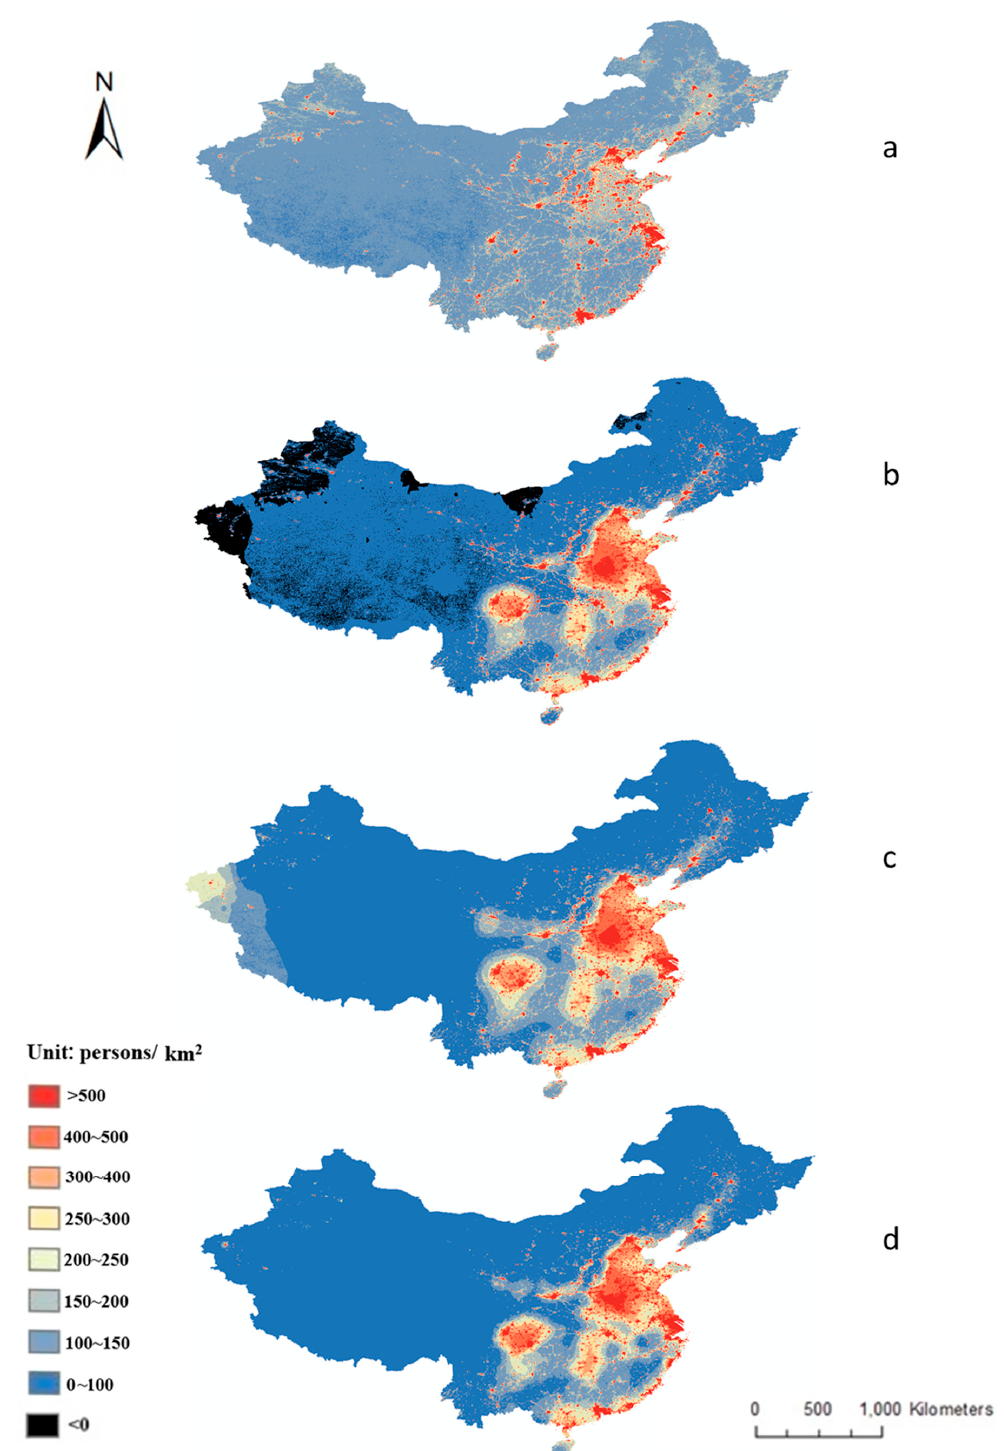
Figure 3. Population density estimation based on ( a ) OLS, ( b ) GWR, ( c ) NNGWR, and ( d ) ANNGWR in 2007 (black color: negative population density).